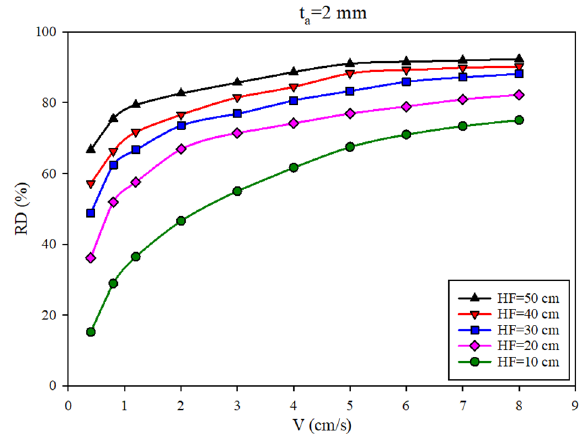
Figure 4. Relative density of pluviated Firoozkooh sand 161 with different parameters of sand pluviator.